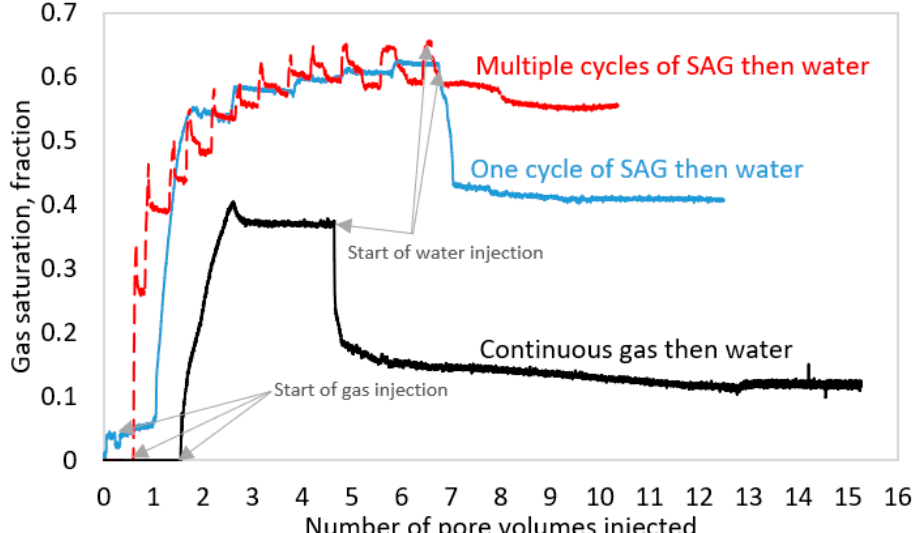
Figure 4. Comparison of the performance of SAG (foam)/gas injection strategies during gas trapping in a sandstone rock sample (BH core sample).